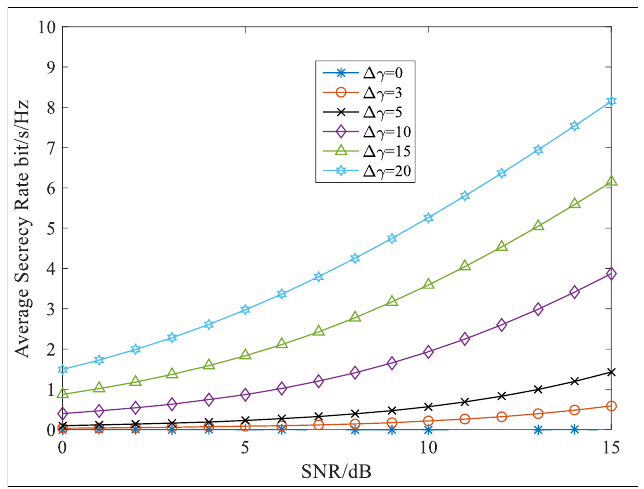
Figure 10. Average secrecy rate versus SNR with errors in γ